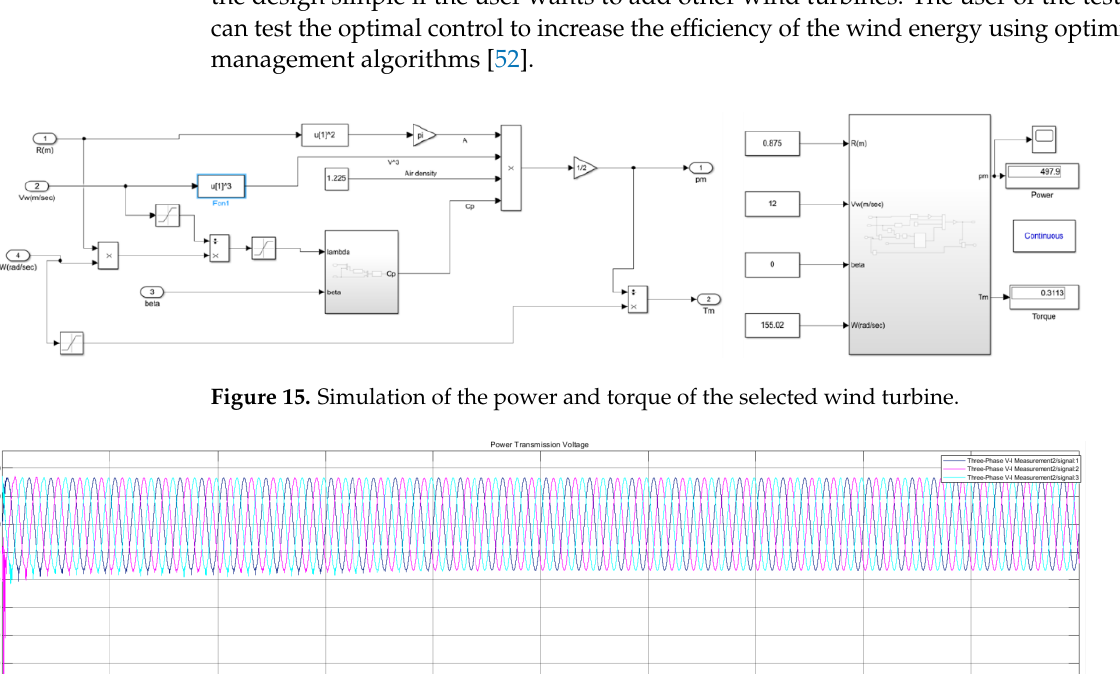
Figure 16. Simulation of voltage output of the selected wind turbine.